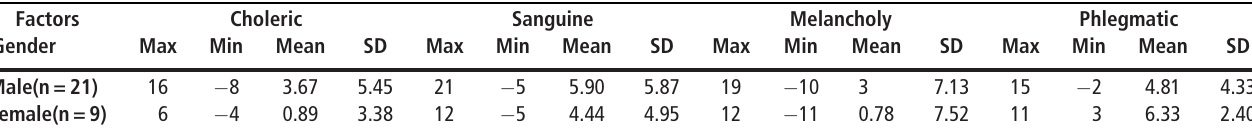
Table 2 TTI Factors according to gender Factors Gender